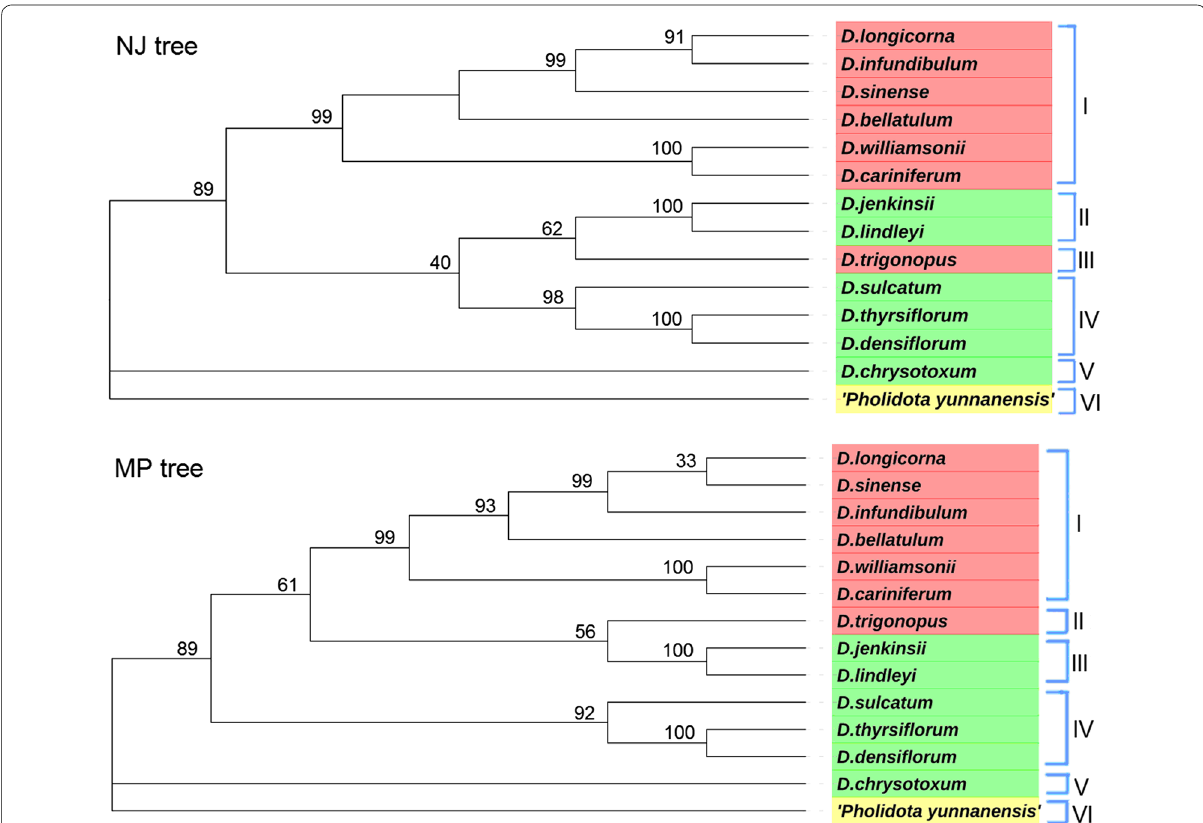
Fig. 2 Neighbor joining (NJ) tree and Maximum parsimony (MP) tree generated using ITS (ITS1-5.8S-ITS2) sequences of Dendrobium species and Pholidota yunnanensis . ( D. longicorna : MK522197; D. infundibulum : MK522210; D. trigonopus : MK522215; D. bellatulum : MK522222; D. williamsonii : MK522234; D. cariniferum : MK522238; D. sinense : MK522249; D. jenkinsii : MK522193, D. chrysotoxum : MK522232; D. thyrsiflorum : MK522235; D. densiflorum : MK522257; D. lindleyi : MK522261; D. sulcatum :